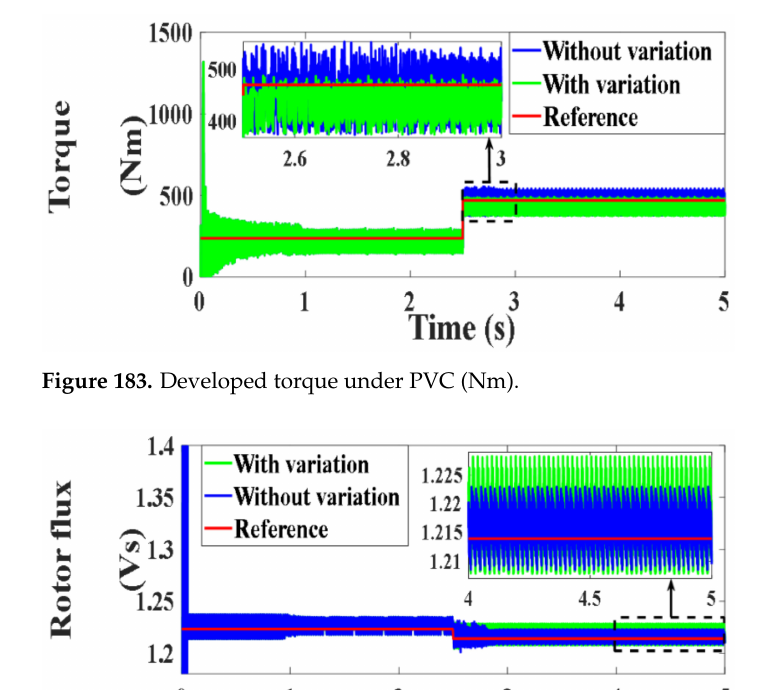
Figure 182. Reactive power under PVC (var).